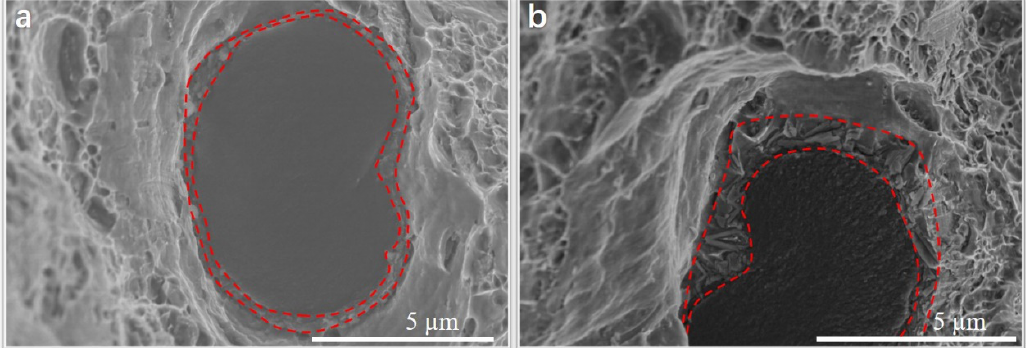
Figure 12. Morphologies fracture surface of SCFs/2024 Al. ( a ) thermal exposure time 1 h; ( b ) thermal exposure time 500 h. Red dotted line area is the Al 4 C 3 interfacial layer .